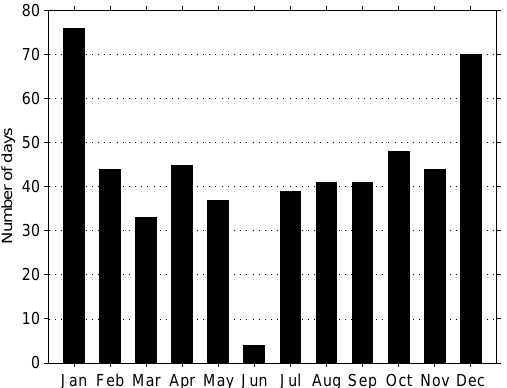
Figure 1. Length of data set in different months available for the current study during the period of